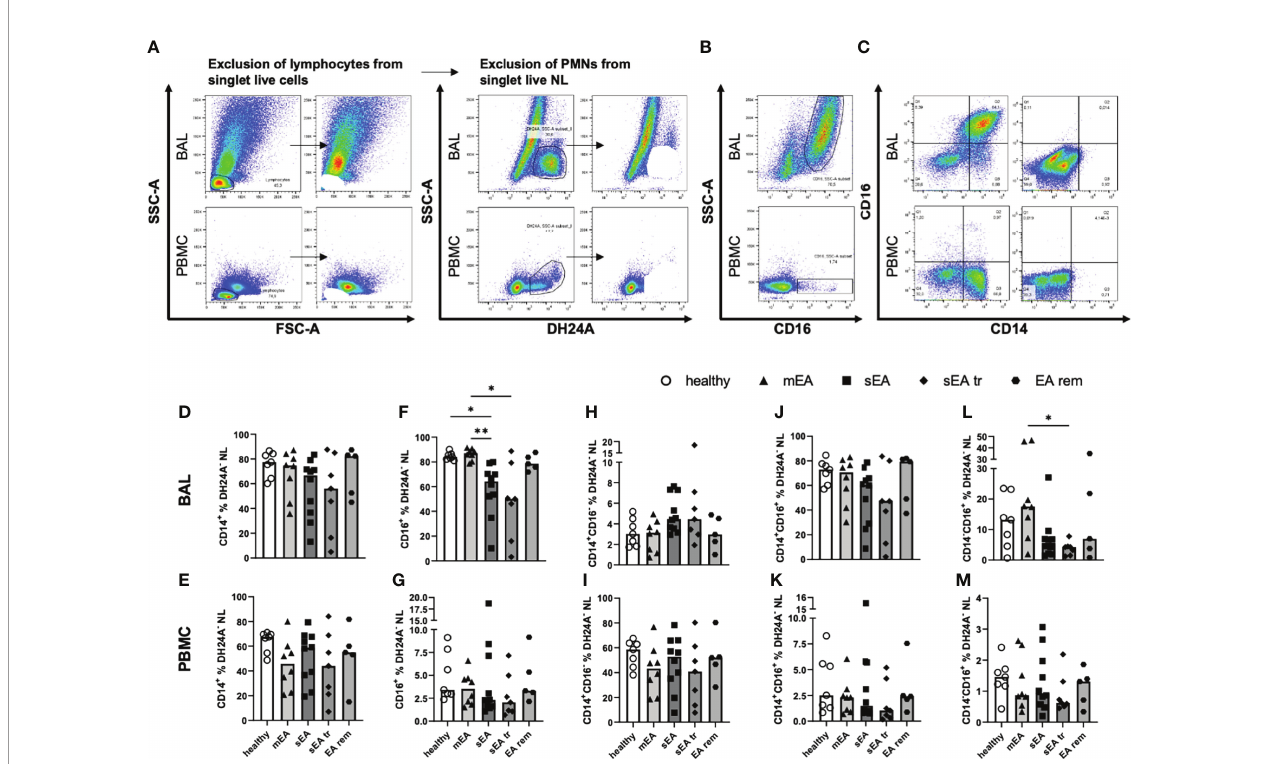
FIGURE 3 | Most BAL macrophages co-express CD14 and CD16. Representative fl ow cytometry plots of samples from one horse with sEA are shown for gating of (A) step-wise exclusion of lymphocytes and PMNs for the further analysis of macrophage (Mph) sub-populations as percentages of DH24A - non-lymphocytes (NL), (B) CD16 staining vs. SSC-A, and (C) CD14 vs. CD16 gating in BAL (upper row), or PBMC (lower row). The frequencies of CD14 + cells among DH24A - NL were similar in samples from horses of all groups in (D) BAL cells, or (E) PBMC. In contrast, the frequencies of CD16 + cells of DH24A - NL were lower in (F) BAL from horses with sEA compared to healthy horses, but not different between groups in (G) PBMC. Analysis of CD16 vs. CD14 expression on BAL cells (H, J, L) and PBMC (I, K, M) revealed similar distribution of CD14 and CD16 expression on macrophages and monocytes between the groups, except (L) a decreased percentage of CD14 - CD16 + cells in BAL samples of pre-treated sEA horses (sEA tr) compared to horses with mild to moderate EA (mEA). Results of individual horses (n=5 – 10 per group) are shown with bars indicating median values and asterisks indicating differences between groups with p<0.05 in Kruskal-Wallis tests. EA rem (equine asthma in